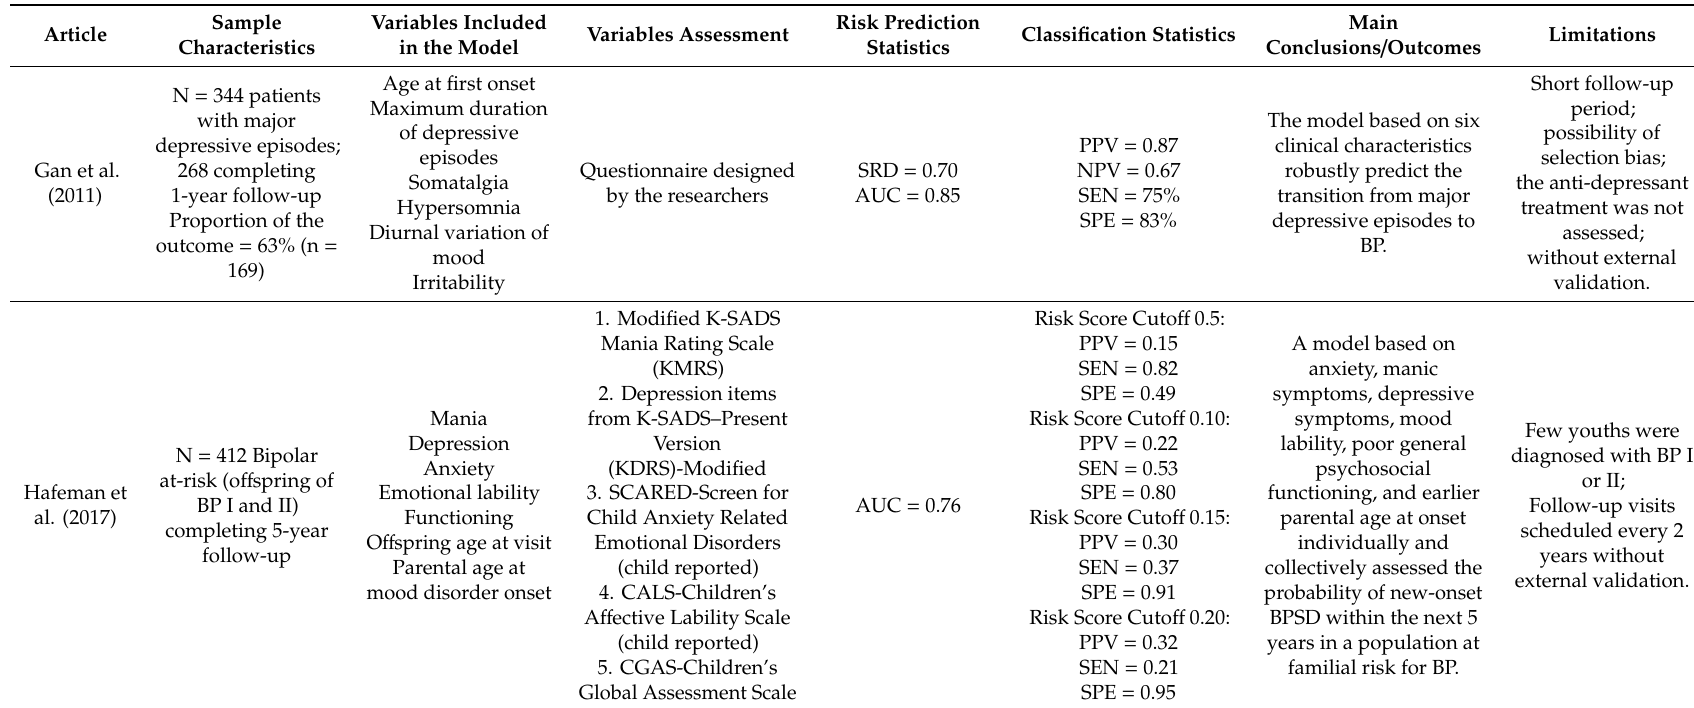
Table 1. Summary of the articles on developing risk prediction models for bipolar disorder